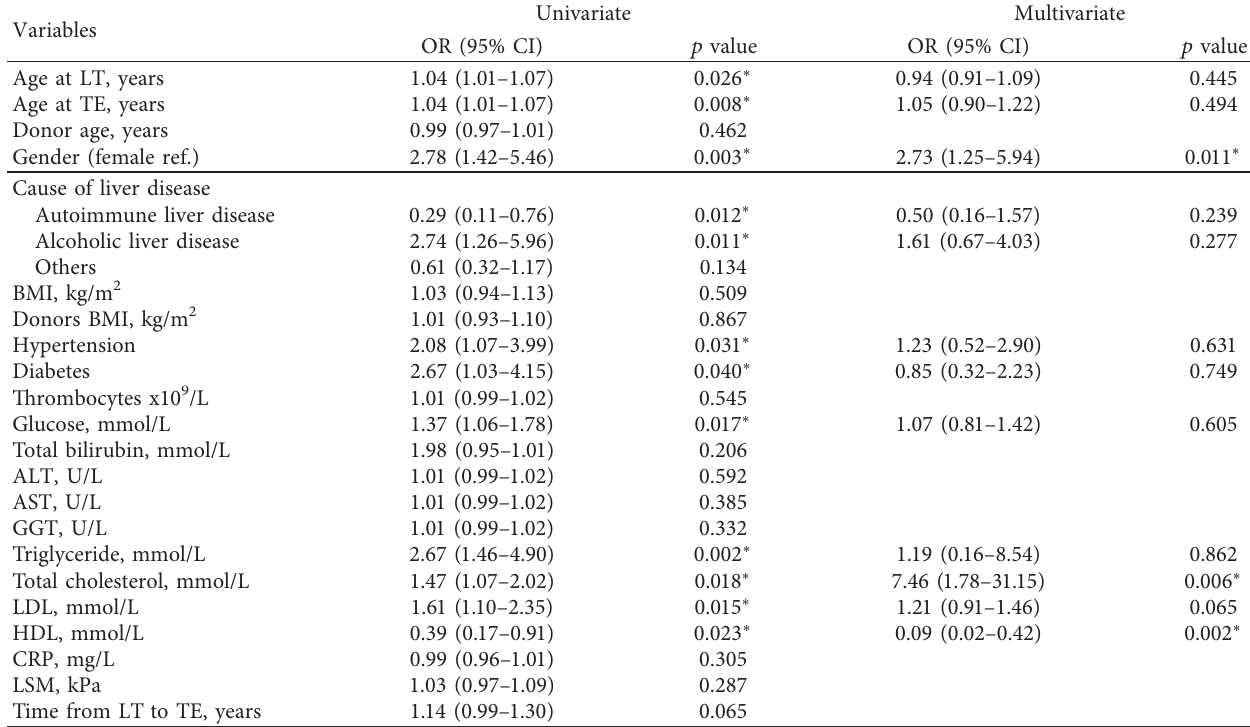
Table 3: Univariate and multivariate analysis of predictors of steatosis (elevated CAP ≥ 238dB).